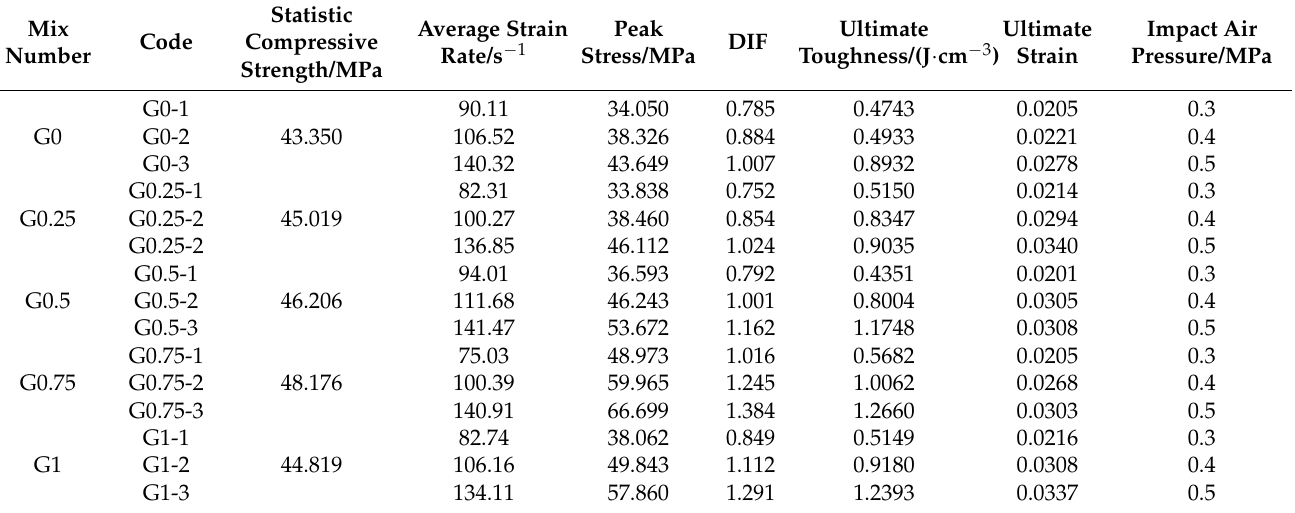
Table 3. Performance parameters of